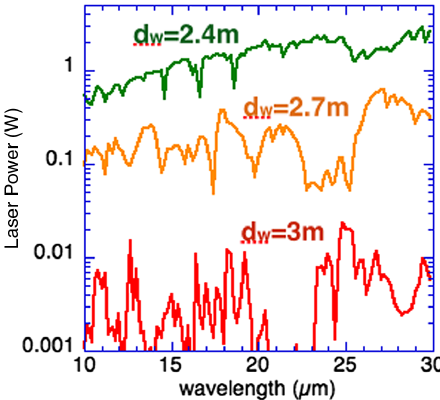
FIG. 14. Laser power versus wavelength at various waveguide length d . w